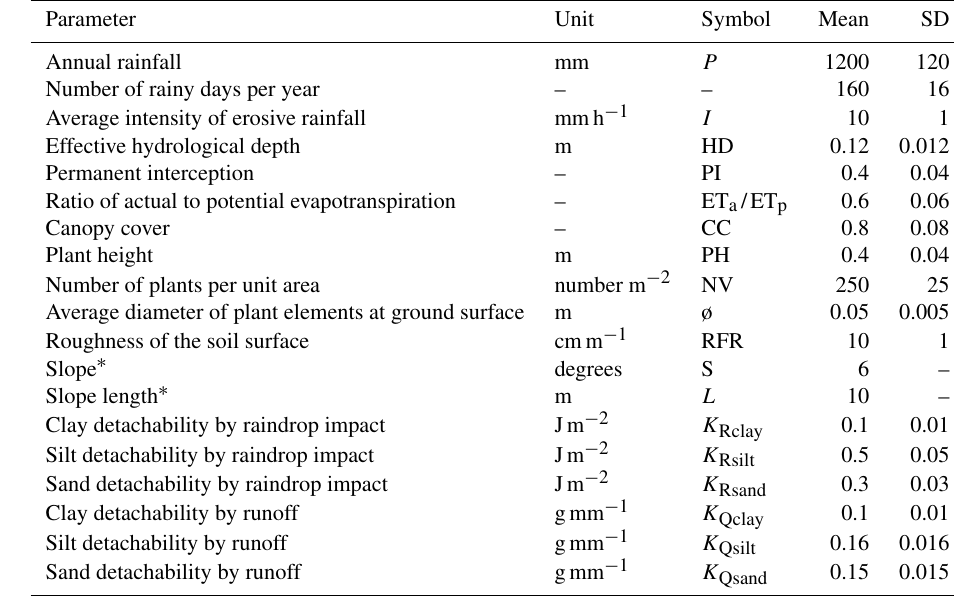
Table 2. Parameter values which were applied to all soil profiles and sampled in the Monte Carlo simulation. Parameter